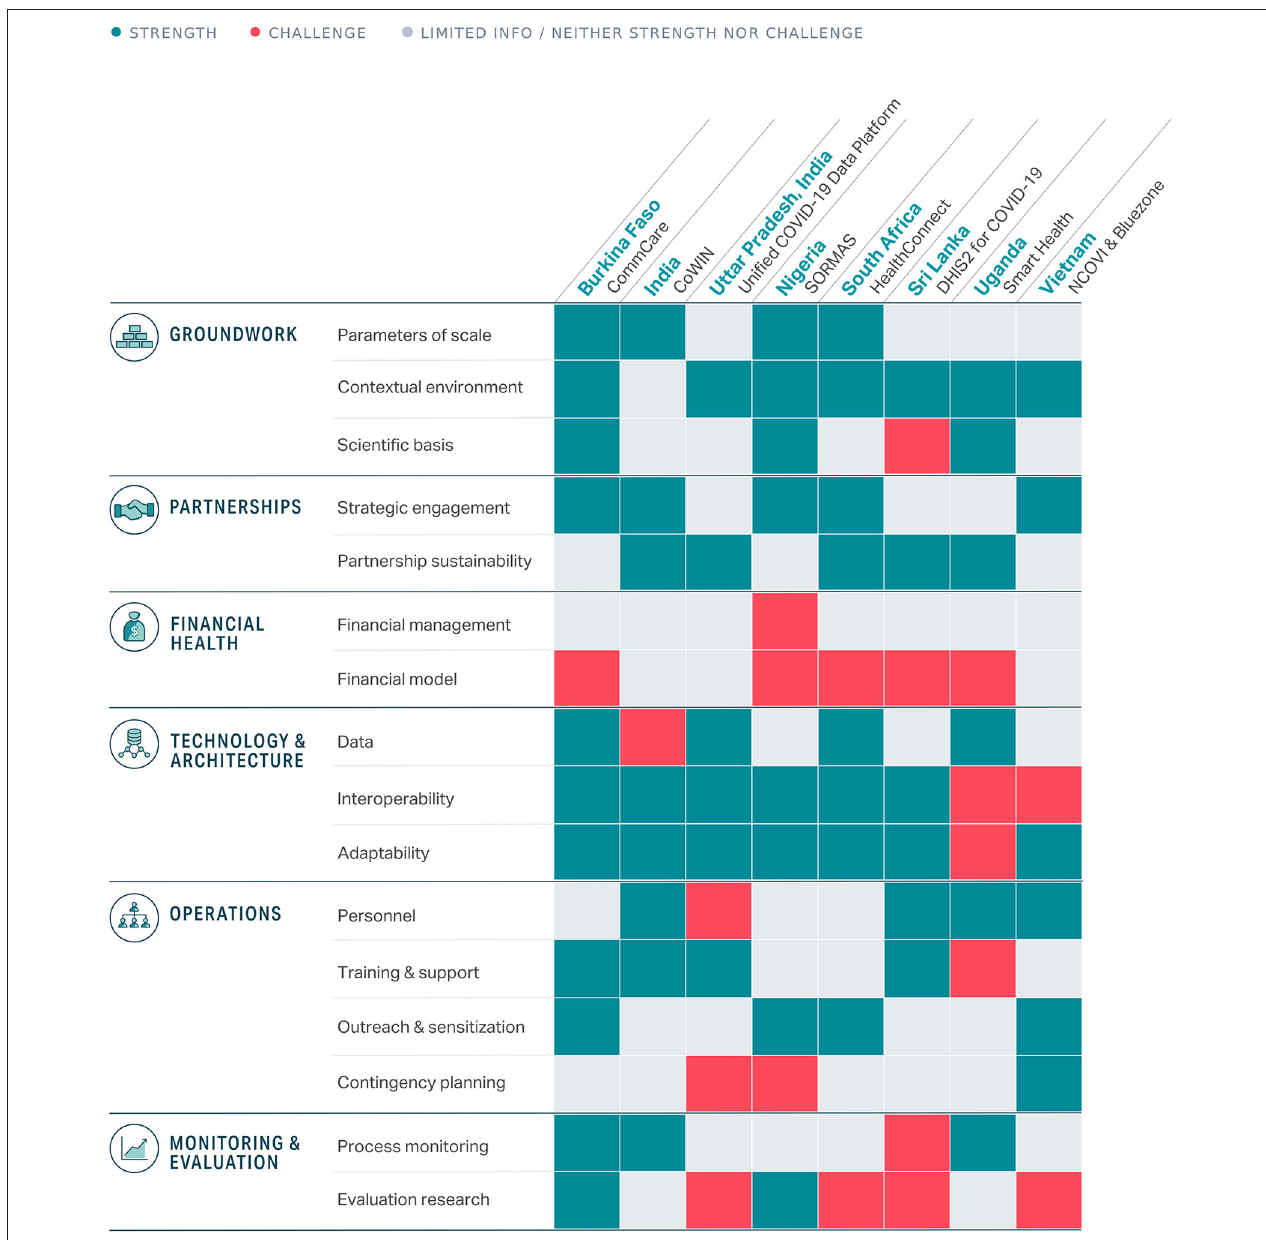
FIGURE 2 | Summary of strengths and challenges across the eight digital tools assessed (detailed descriptions available in Supplementary Table 2